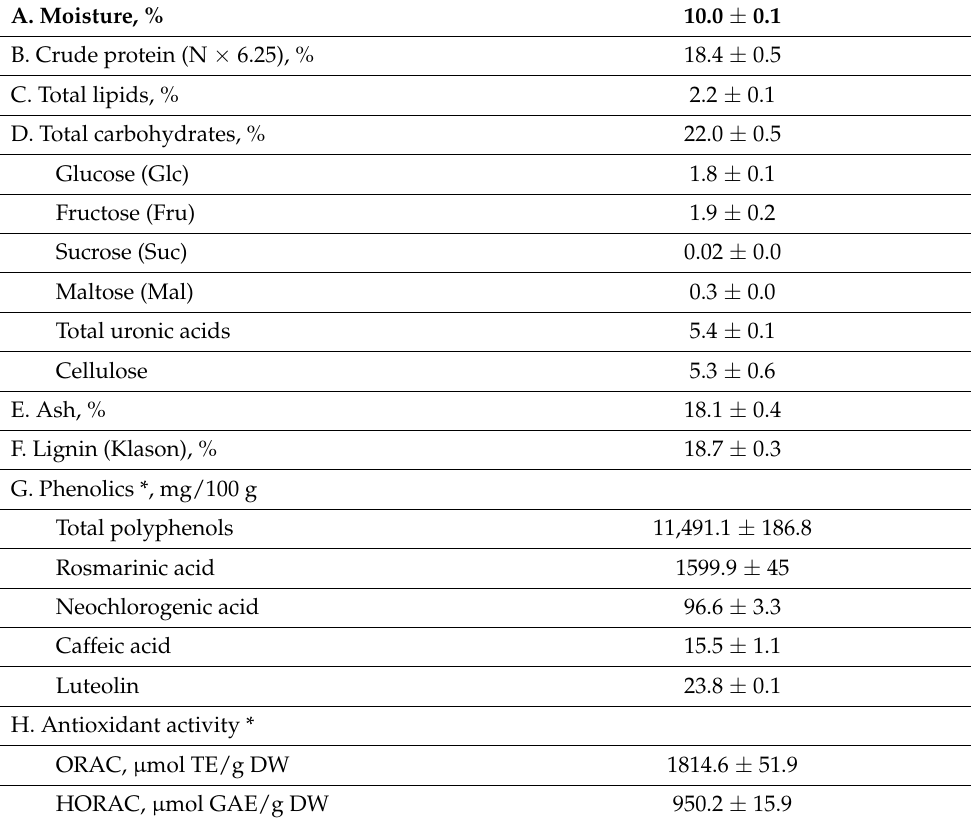
Table 1. Chemical characterization and antioxidant activity of lemon balm